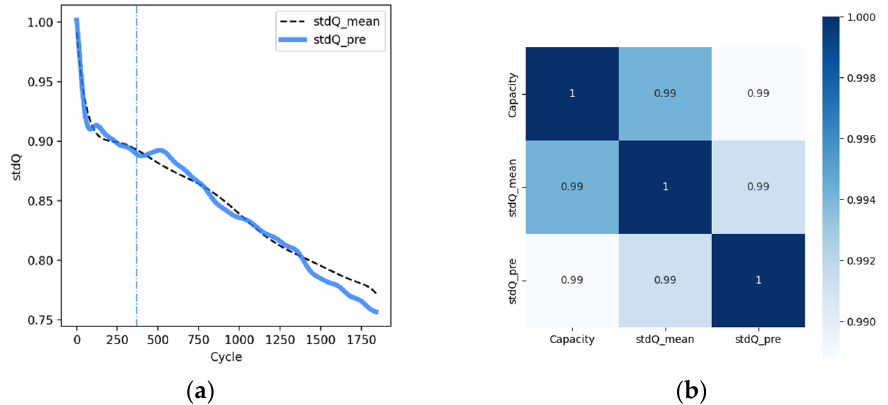
Figure 2. The prediction results of the stdQ for the battery pack: ( a ) the predicted future stdQ of the battery pack; ( b ) the correlation coefficient between observed and predicted HIs and the capacity.